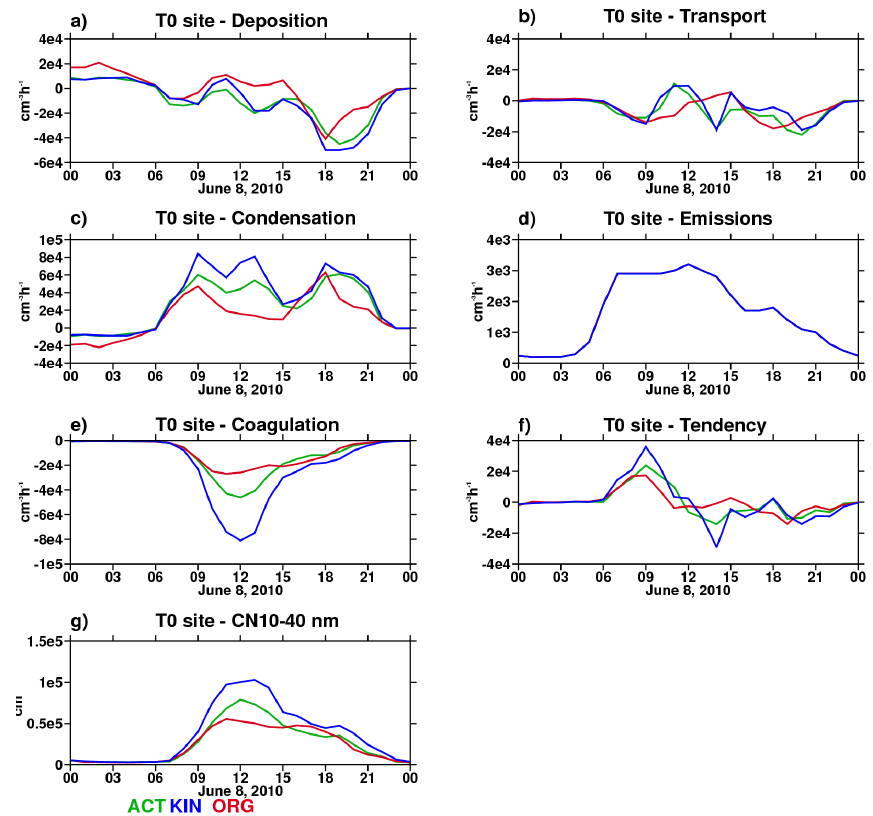
Figure 9. Budget diagnostic terms for 10–40nm particles at the T0 site on 8 June: (a) deposition; (b) transport; (c) condensation; (d) emis- sions; (e) coagulation; (f) total tendency; and (g) particle number